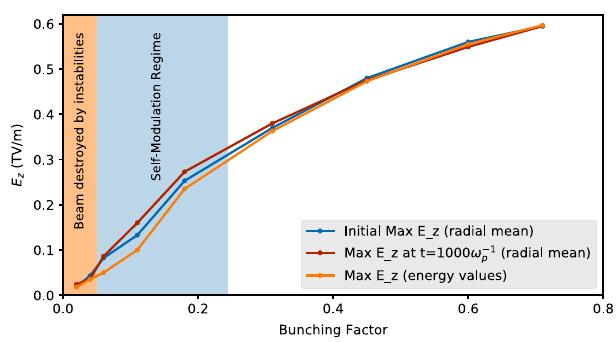
FIG. 7. The variation of initial, final and average maximum axial longitudinal electric field with bunching factor, B .